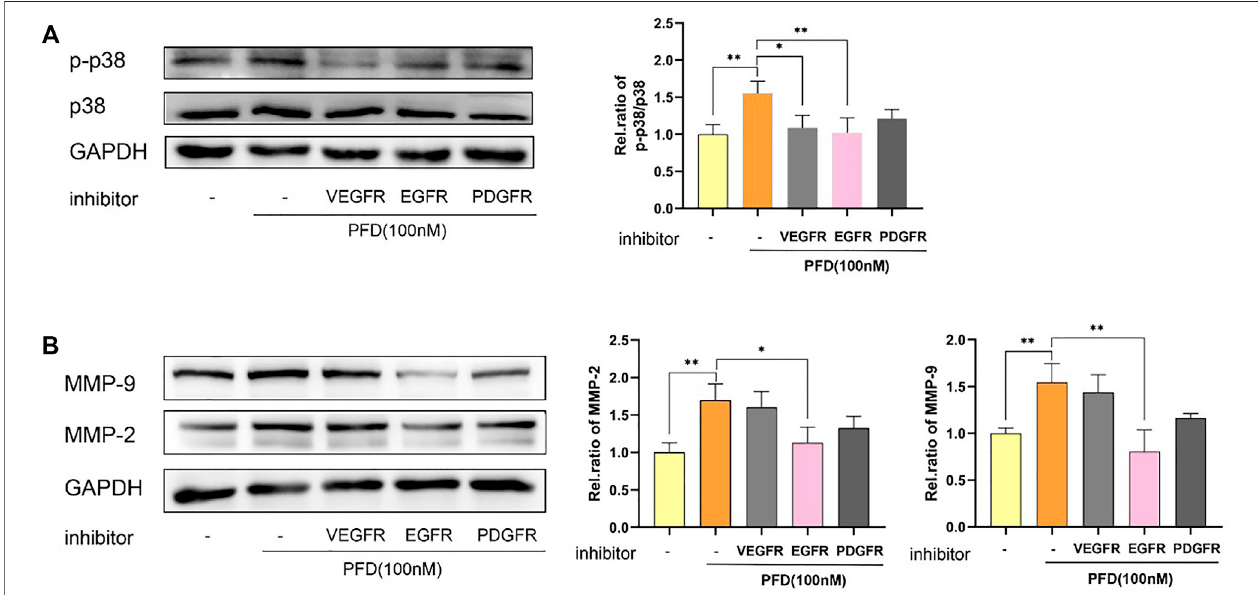
FIGURE 6 | PFD increases MMP-2 and MMP-9 protein expression predominantly through activation of the p38 pathway and is EGFR-dependent. EA.hy926 cells werepre-treatedwithdifferentpharmacologicalinhibitorsfor30 minpriortoPFD(100 nM,0.5/24 h)stimulation,whichwasfollowedbyassessmentofp-p38andMMP- 2/9 expression in cell lysates by western blot analysis. (A) Inhibitors of VEGFR and EGFR signi fi cantly inhibited the PFD-stimulated increase in p-p38 expression. (B) Inhibitors of EGFR signi fi cantly inhibited the PFD-stimulated increasement of MMP-2 and MMP-9 expression. * p < 0.05; ** p < 0.01. VEGFR-i (100 nM), EGFR (100 nM), PDGFR-i (1